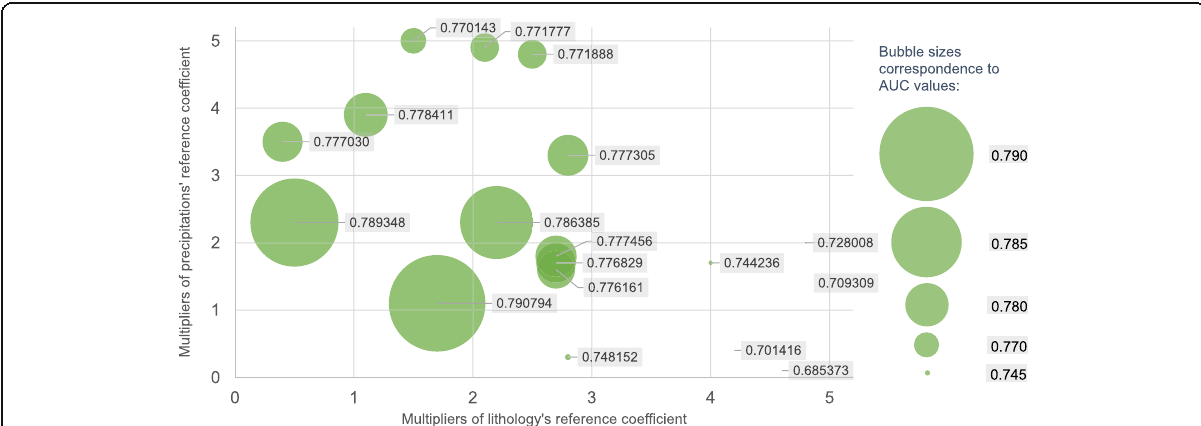
Fig. 11 AUC values resulting from random combinations of lithology and precipitations coefficients' variations of the reference outputs from the percentile-discretization LOGIT model. Legend: Green bubble sizes represent the AUC values, whose area has been magnified according to the artifice (AUC*100)^100. X-axis show the multipliers of the lithology factor ’ s reference coefficients and Y-axis show the multipliers of the precipitations factor ’ s reference